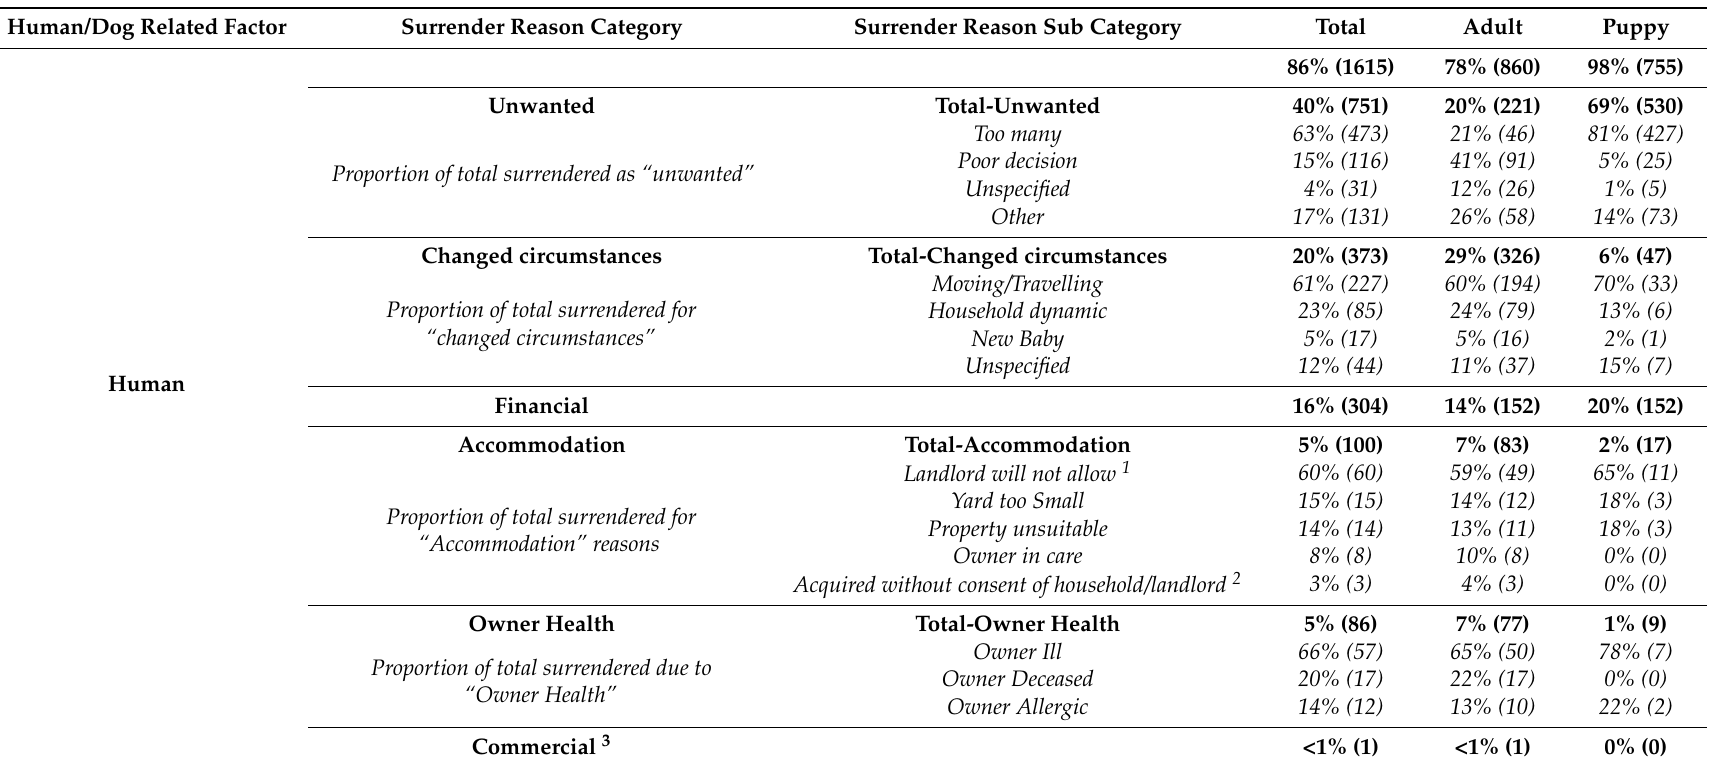
Table 6. Reasons for surrender organized according to human or dog related factors for 1876 dogs surrendered to RSPCA-QLD shelters in 2014 (a surrender reason was not recorded for 876 surrendered dogs, and therefore were not included in the